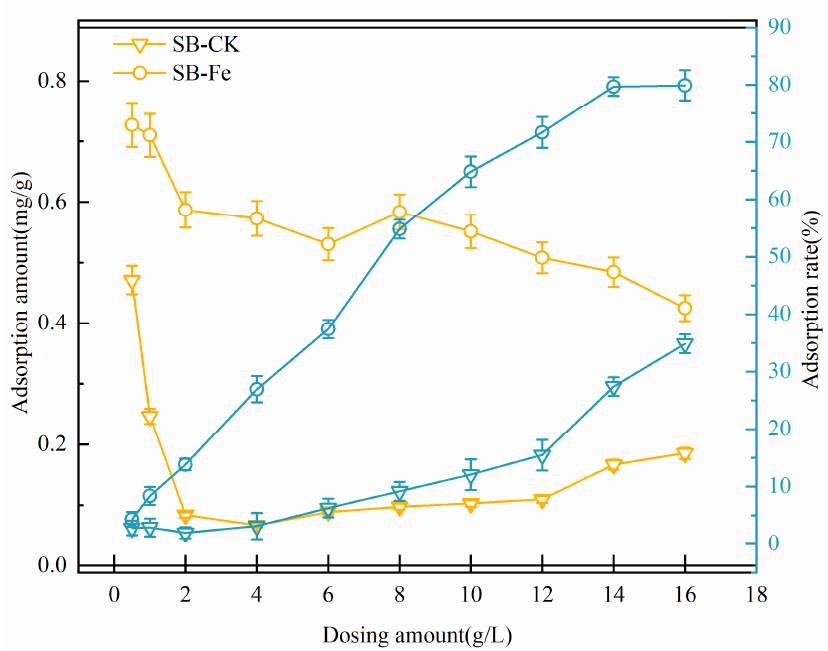
Figure 3. Effect of adsorbent dosage on phosphate uptake (left-hand axis) and uptake rate (right-hand axis).